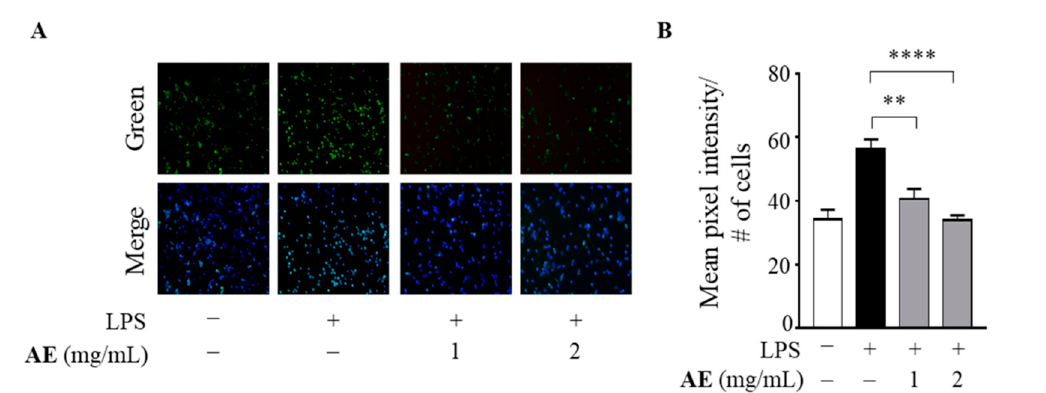
Data are expressed as means ± SDs ( n = 3).